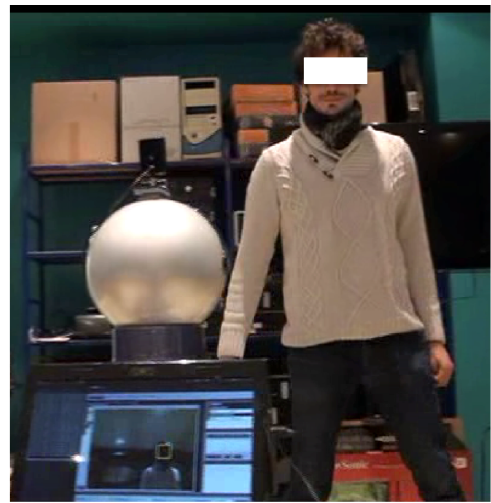
Figure 9. Picture of the face-to-face communication experiment. The detected face is marked with a yellow rectangle in the robot